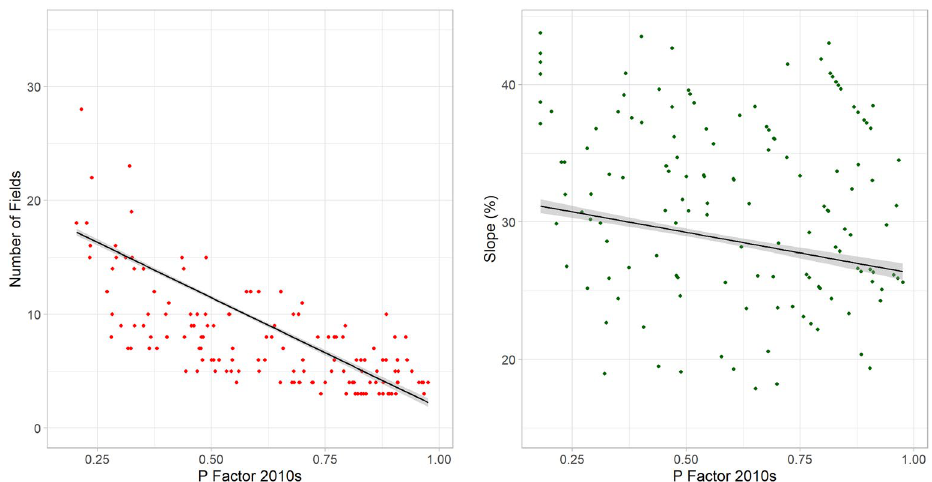
Figure 10. The 2010s’ P factor values compared with 2010s’ Number of Fields and Slope (%) trends. Image generated with software RStudio Desktop 2022.07.2 + 576 (https:// www. rstud io. com/).